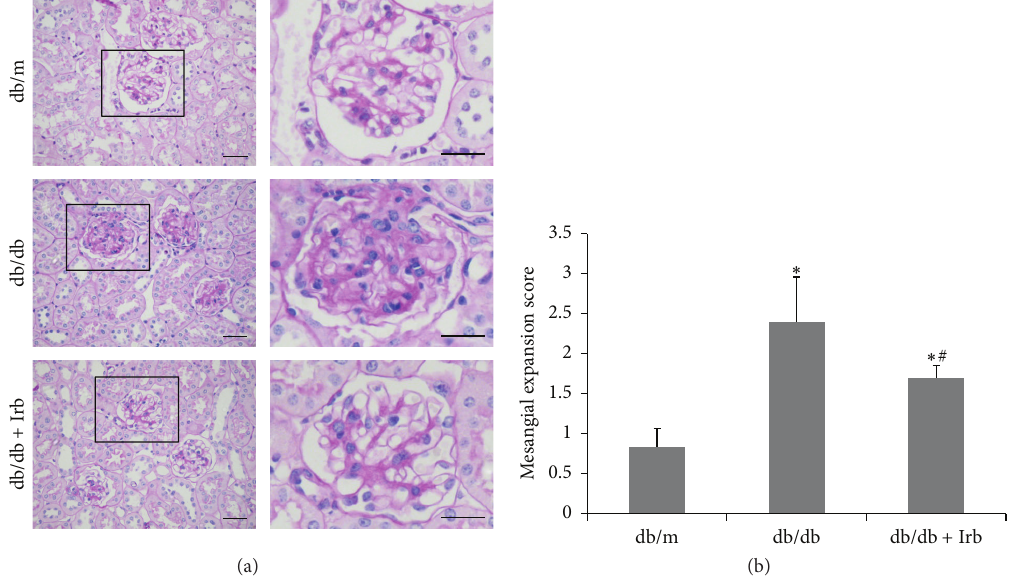
Figure 2: Irb alleviated diabetes-induced renal pathological changes. (a) Representative fields of the glomerulus stained with PAS (scale bars: 50 𝜇 m). (b) The mesangial expression score increased in db/db mice and decreased in db/db mice with Irb treatment. The bars in panel (b) show the mean expression in arbitrary units (error bars, S.D.). ∗ 𝑃 < 0.05 compared with db/m; # 𝑃 < 0.05 compared with db/db, 𝑡